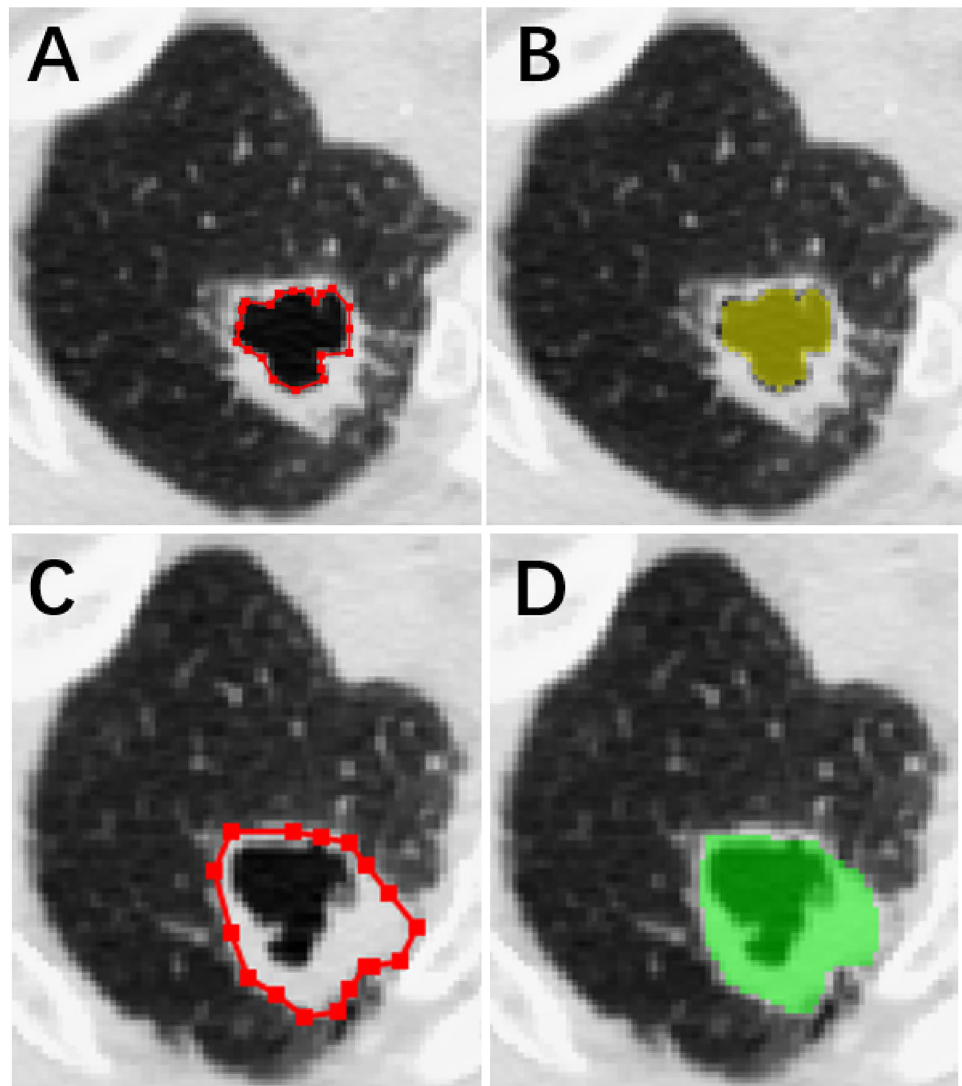
Figure 1. A 60-year-old man with SSC in the upper lobe of the right lung. ( A ) Edge of the cystic airspace. ( B ) Completed segmentation image (volume and area of this layer were 158.4 mm 3 and 148.3 mm 2 , respectively). ( C ) Edge of the entire lesion. ( D ) Completed segmentation image (volume and area of this layer were 541.8 mm 3 and 433.4 mm 2 ,